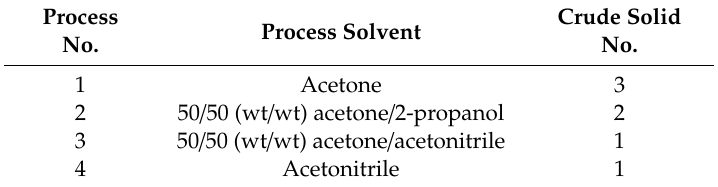
Table 3. Overview of the selected process solvents and the corresponding crude